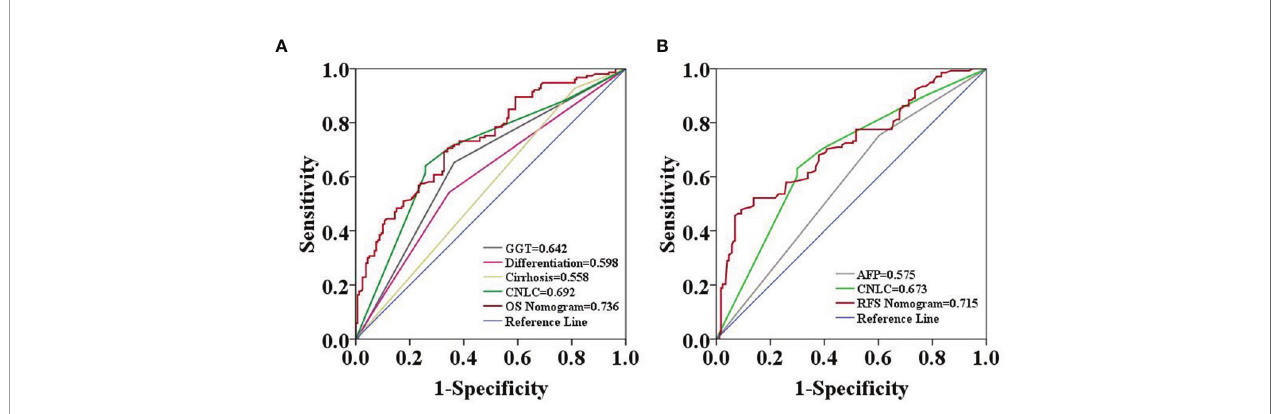
FIGURE 4 | Predictive accuracy comparison of each variable included in the OS (A) and RFS (B) nomograms by ROC curve analyses in the primary cohort. The ROC curves showed that the two nomograms were superior to the other variables in